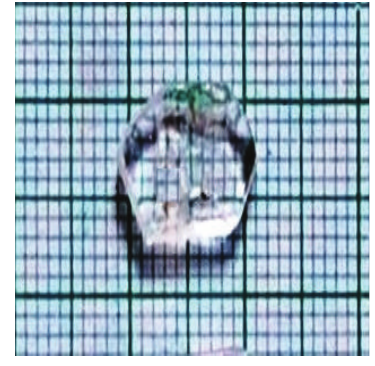
Figure 2: Photograph of as-grown LSP crystal.